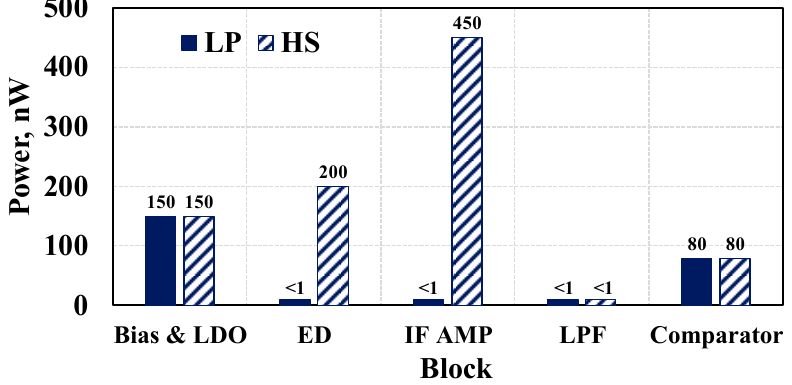
Figure 20. Measured power consumption of each block.